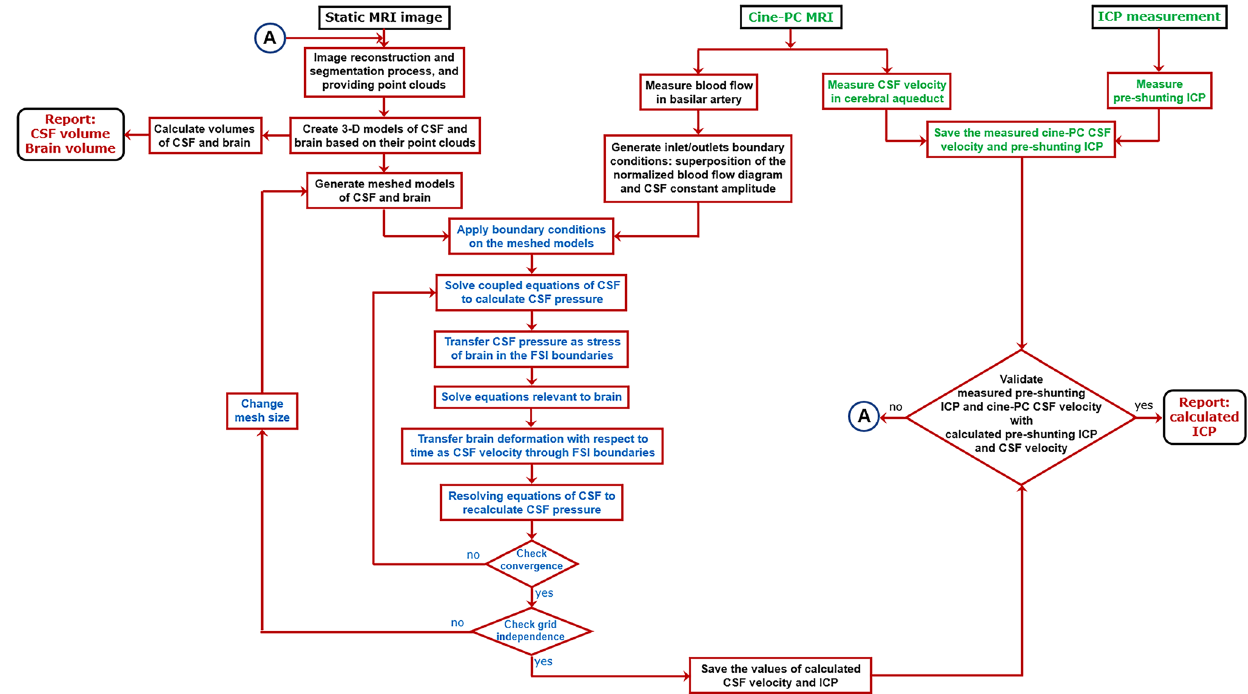
Fig. 6 Methodological work fl ow. The work fl ow included FSI method (blue text), measured parameters (green text), and calculated parameters (maroon